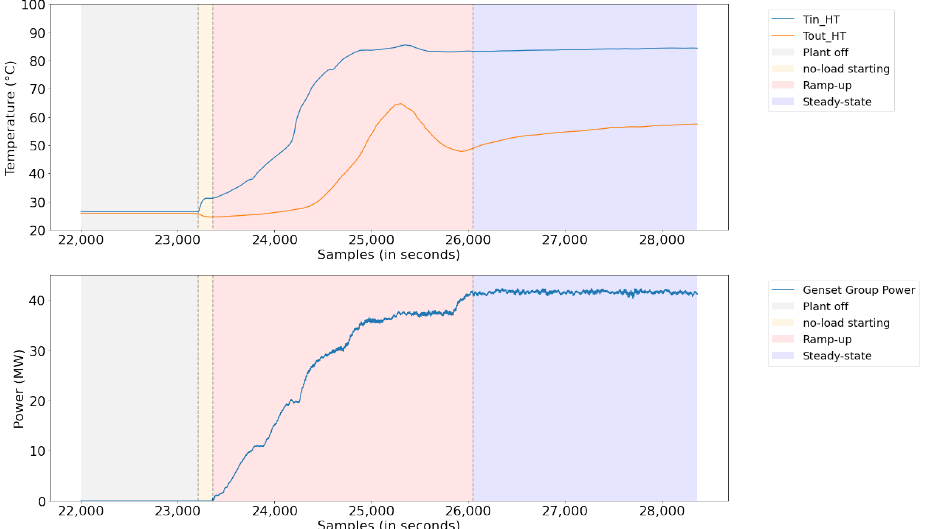
Figure 6. Inlet and outlet temperature in the radiator during pre- and poststart periods of